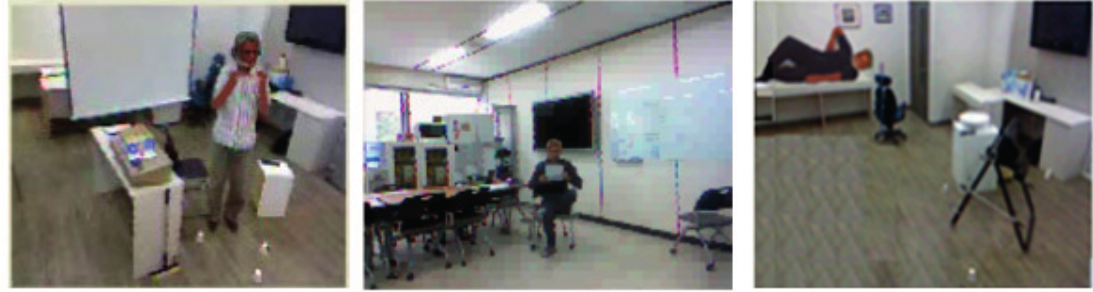
Figure 9. Sample from our datasets showing all three smart indoor activities environments. Smart home ( left ), Smart Office ( middle ), and Smart Hospital ( right